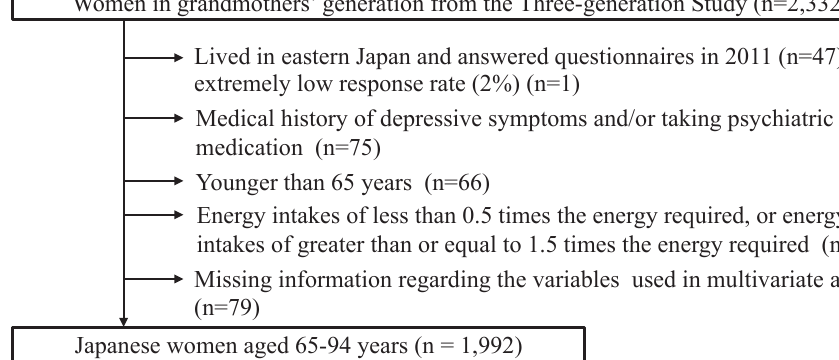
Figure 1. Exclusion criteria for association between intake of co ff ee and depressive symptoms among elderly Japanese